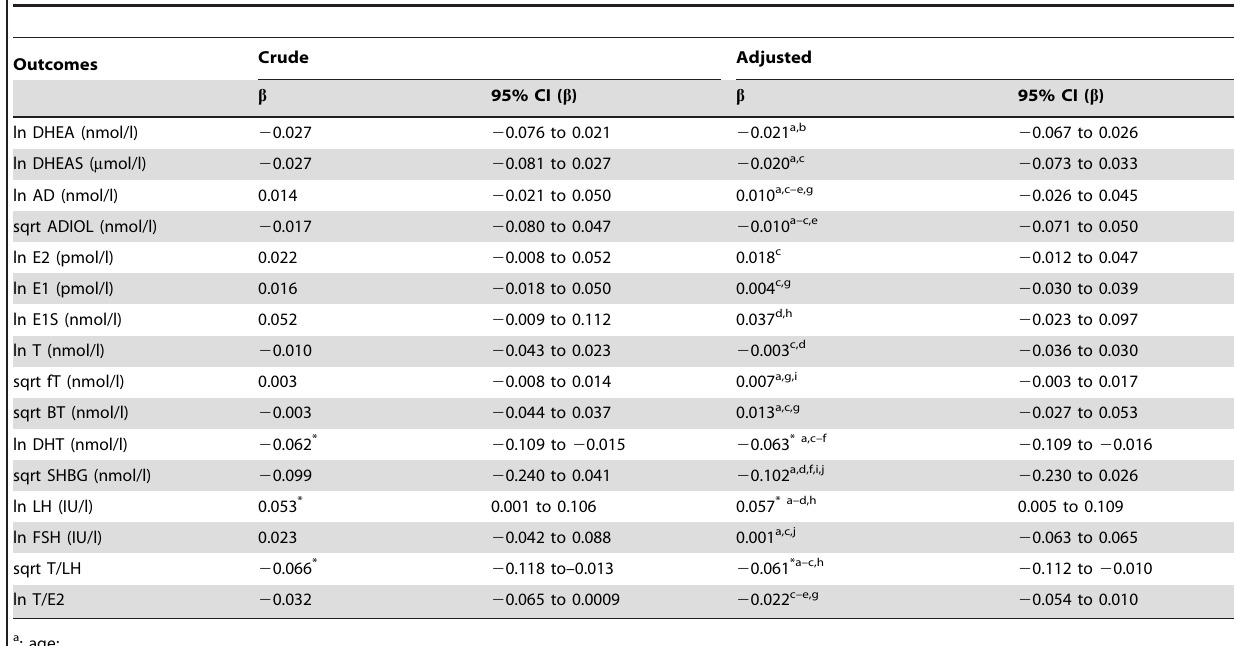
Table 3. Regression coefficients ( b ) for association between serum pp 9 DDE levels and the outcome variables.